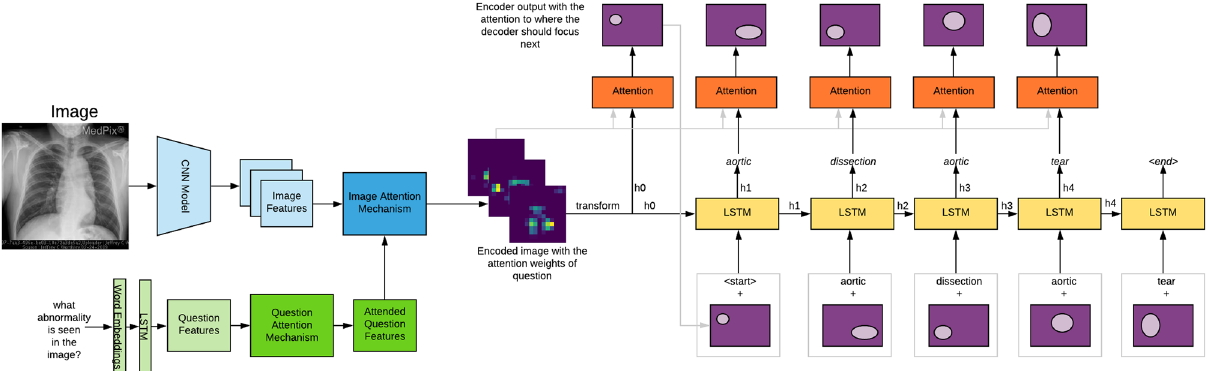
Figure 4. The architecture used for the answer generation task. This module takes the image and the question as the input. It generates the feature vectors for both and produces the combined vector after fusing them using MFB as part of the image-question co-attention mechanism. This is followed by an LSTM-based decoder to generate the answer. The two major components of this decoder are—the attention mechanism and teacher forcing. The attention mechanism helps the model in focusing on various parts of the image while generating a word, and the teacher enforcing helps the model converge